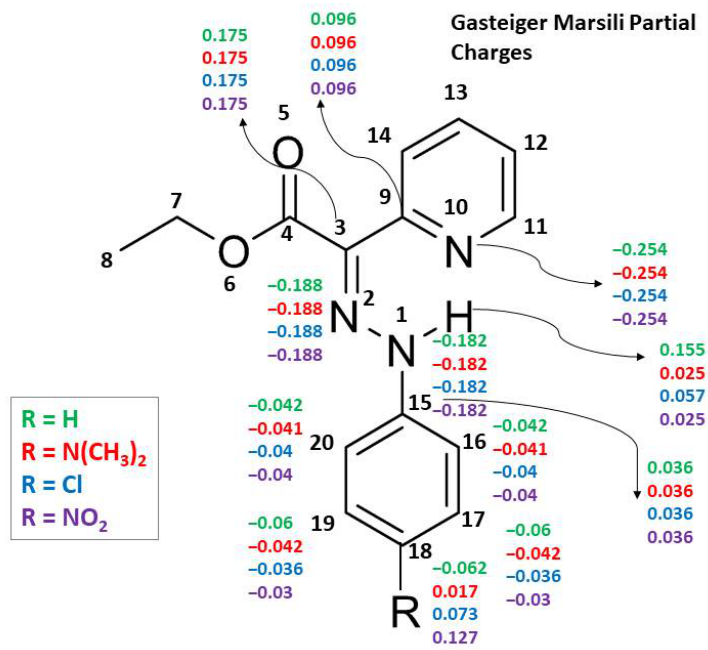
Figure 5. Gasteiger–Marsili partial charges for selected atoms of compounds 1 , 2 , 7 and 11 . RMSD values for bond changes of the main structural fragment (i.e., atoms N1, N2, C3, C9, N10 and H21) show very small changes in the bond lengths (see Supplementary Tables S14–S18). The major variation is for the hydrogen bonds (N10 ⋯ H21, O5 ⋯ H21), which vary around 0.01–0.05 Å.